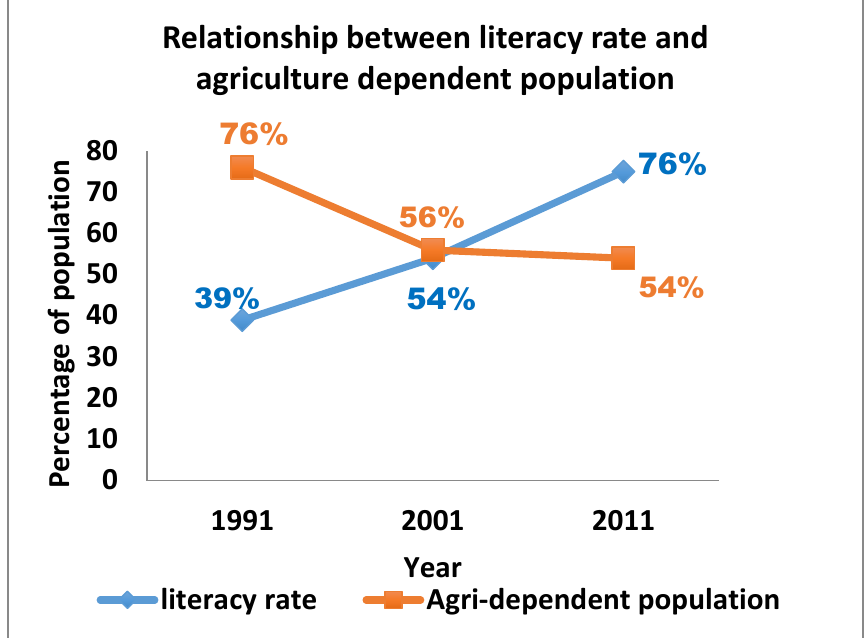
Figure 14. Relationship between literacy rate (percentage value) and agriculture-dependent population.